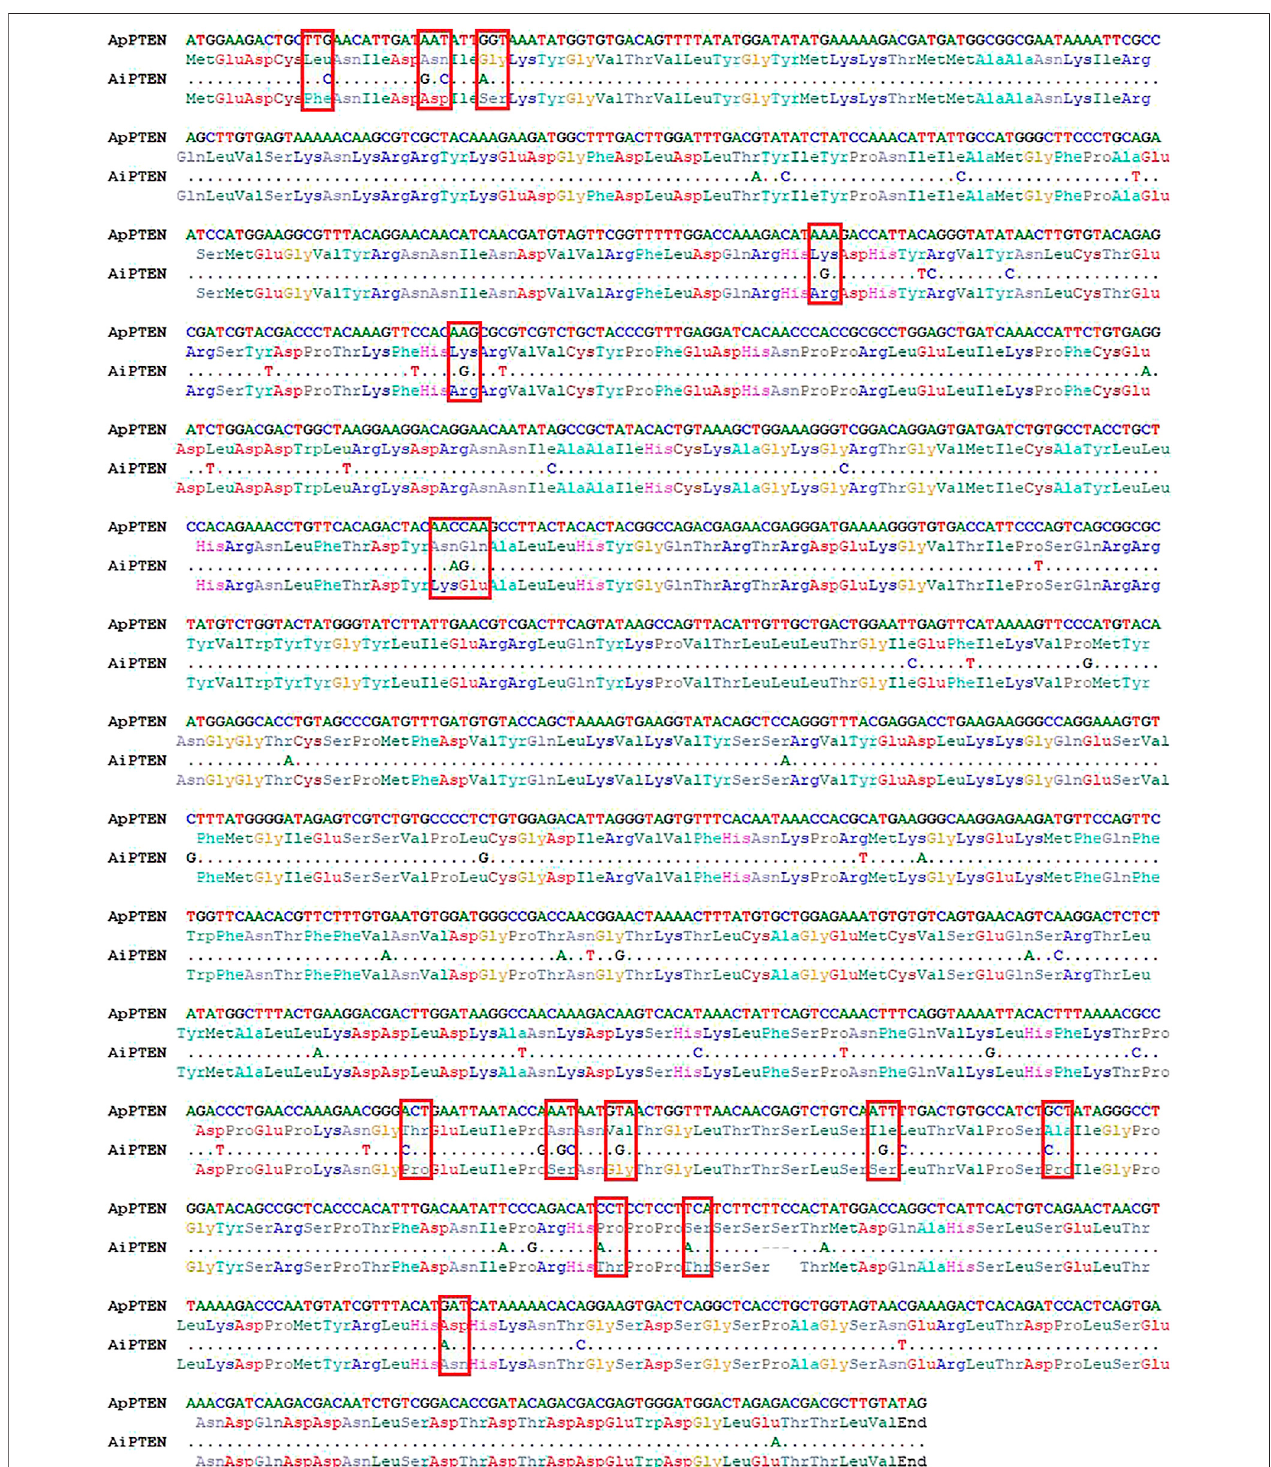
FIGURE 1 | The nucleotide and amino acid variation between ApPTEN and AiPTEN.